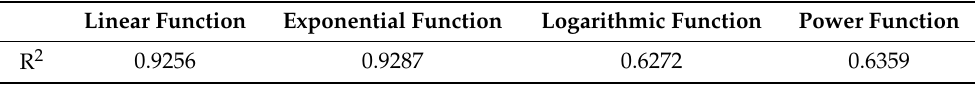
Table 2. Average of coefficient of determination (R 2 ) of the curves.